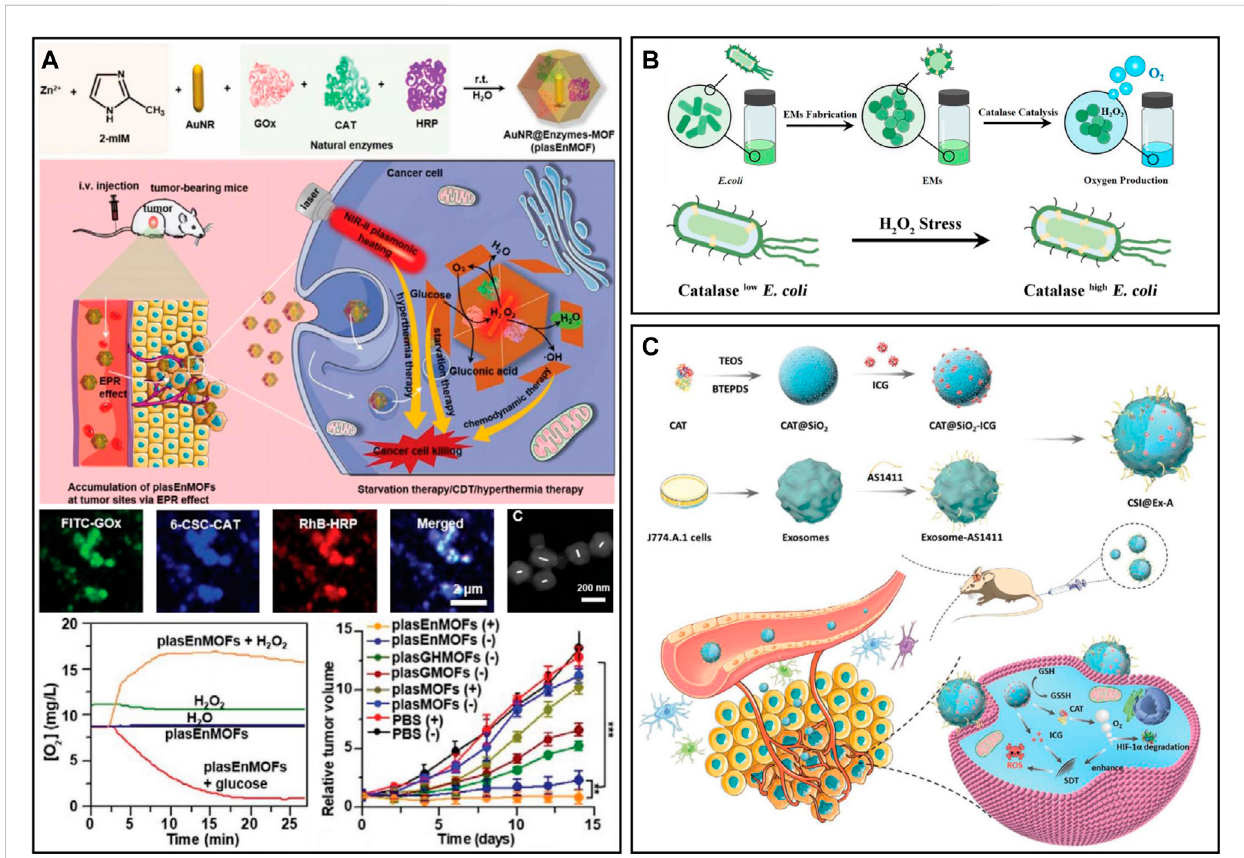
FIGURE 3 (A) PlasEnMOFforenzymaticcancertherapy.Reproducedfromref.40withpermissionfromWiley,copyright2022. (B) EMsfortumorhypoxiarelief. Reproduced from ref. (Huang et al., 2015) with permission from ACS Publications, copyright 2021. (C) CSI@Ex-A for O 2 -self-supply SDT. Reproduced from ref. (Qin et al., 2021) with permission from Wiley, copyright